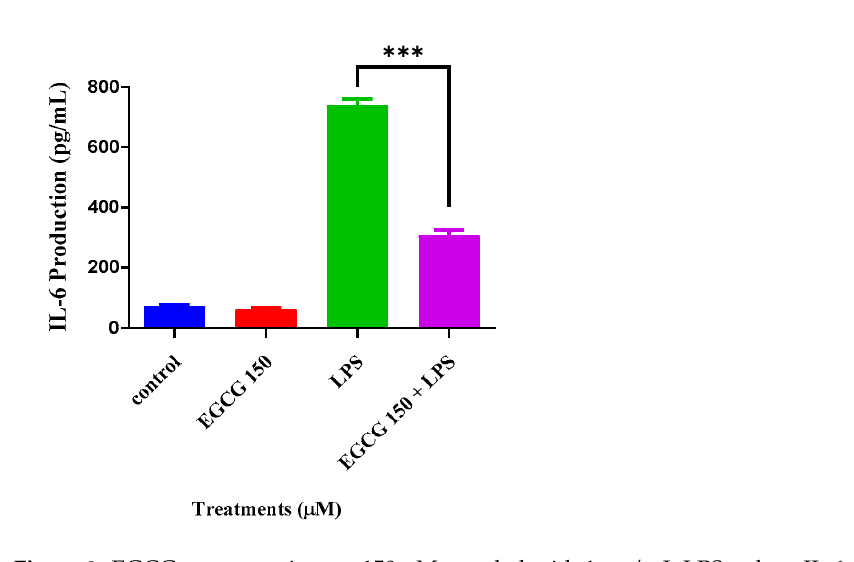
effects on the specific mRNA expression of the gene. Supplementary Table S1 details the inflammatory cytokine function and fold change.